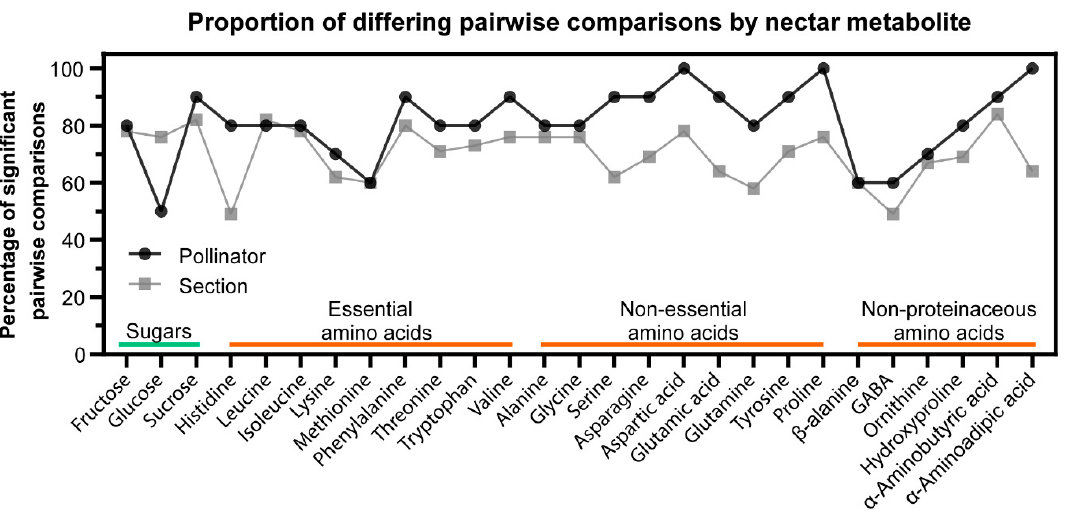
Figure 7. Proportion of significant pairwise comparisons ( q -values < 0.05) for each Nicotiana nectar metabolite when summarized by phylogenetic section (grey, a total of 45 possible pairwise comparisons, Table S3) or preferred pollinator (black, a total of 10 possible pairwise comparisons, Table S4).